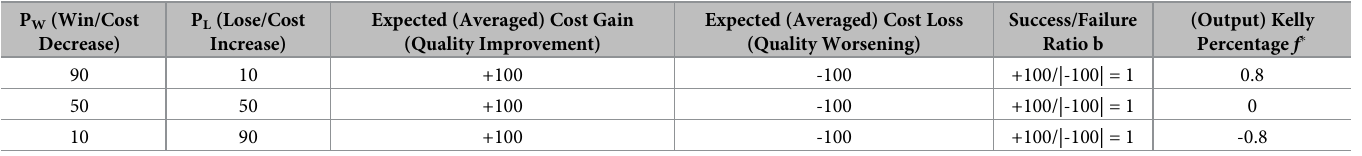
Table 8. Example calculation for the Kelly criterion for P (1) = 90, 50 and 10 and net-odds b = 1. P W (Win/Cost